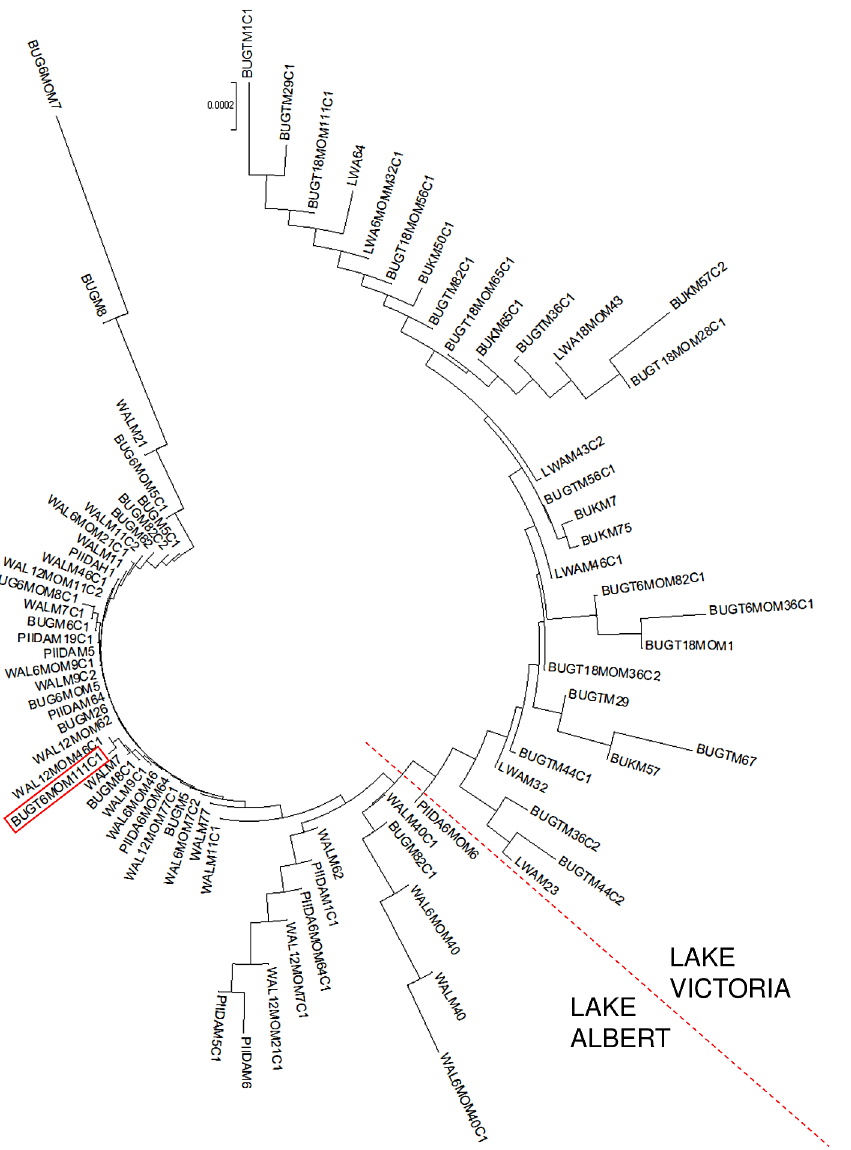
Figure 5. Neighbour joining tree based on the net mean genetic distances between individual infrapopulations sampled at baseline and in follow-up surveys. The red-dotted line indicates the almost-complete segregation between infrapopulations from Lake Albert and those from Lake Victoria. The red rectangle highlights one infrapopulation from Lake Victoria which clusters with infrapopulations from Lake Albert. BUG=Bugoigo; WAL=Walukuba; PIIDA=Piida; BUGT=Bugoto; BUK=Bukoba; LWA=Lwanika. 6 MO=6 month follow-up; 12 MO=12 month follow-up; 18 MO=18 month follow-up. M*=identification code for a mother host; M*C1 or M*C2=identification code for a child host.